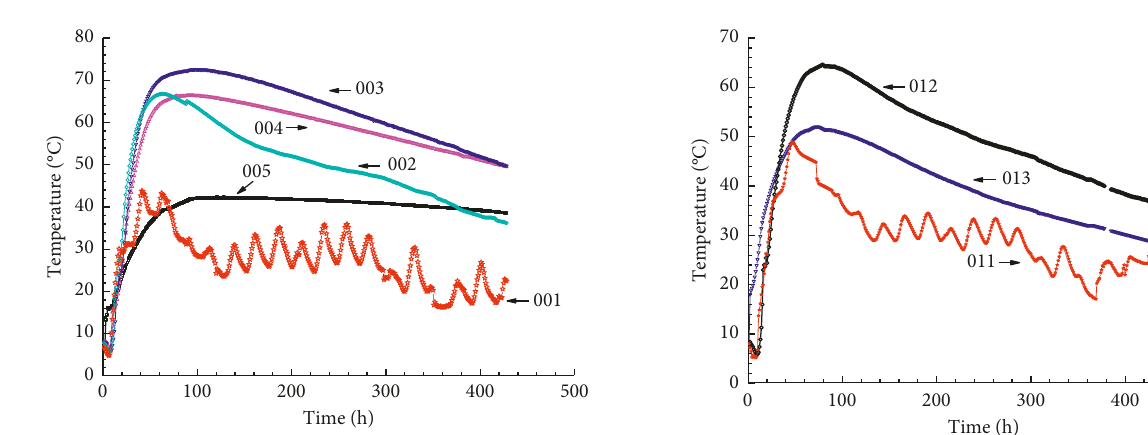
Figure 6: Measured temperature evolution of Points 011–013.